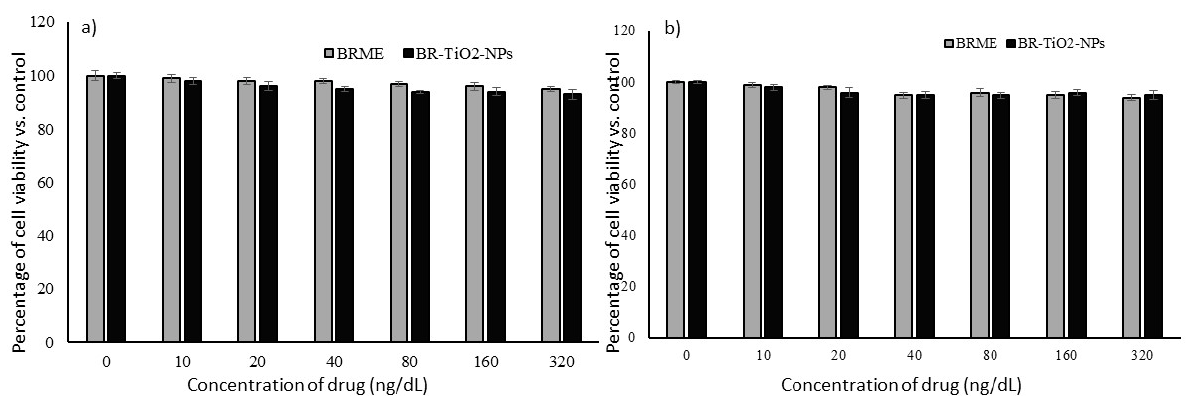
Figure 2. Effect of BRME and BR-TiO 2 -NPs treatments on cellular proliferation levels in hMSCs ( a ) and adipocytes ( b ) after 48 h. Each value is a mean ± SD ( n = 6).